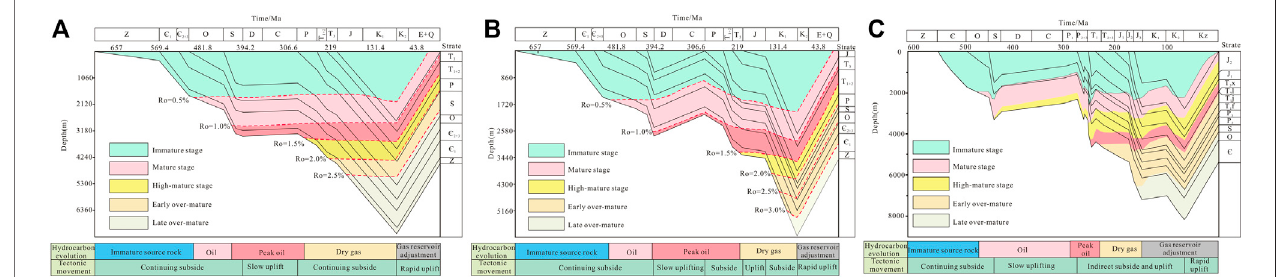
FIGURE14| Aggregativemodeloftheshaleburialhistory,hydrocarbongenerationandstructuralevolutionoftheWufeng-LongmaxiFormationinthe (A) Weiyuan, (B) Luzhou, and (C) Changning areas in southern Sichuan.